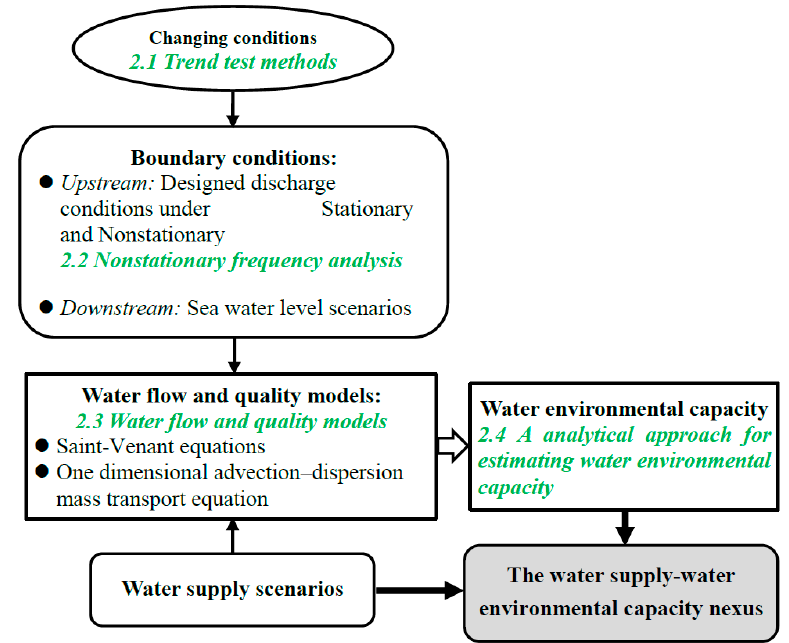
Figure 1. Schematic computational flow chart of water supply-water environmental capacity nexus: all “ ” are the inputs for water flow and quality models. “ ” is the inputs for water environmental capacity while “ ” indicates the input for the nexus.